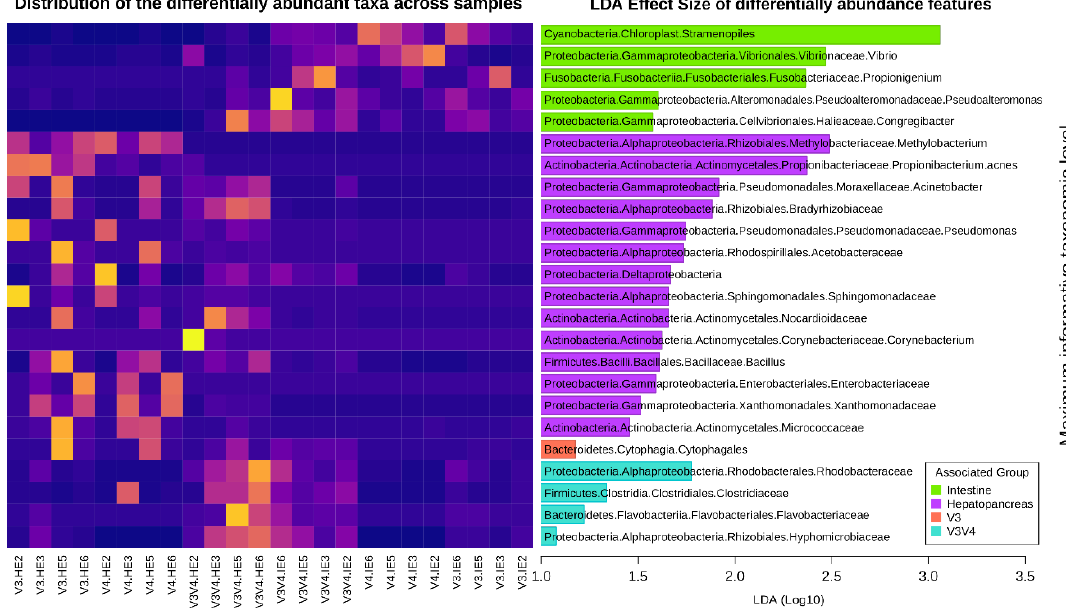
Figure 11. Distribution of differentially abundant multi-level taxa selected by the Linear discriminant analys Effect Size (LEfSe). The heatmap represents the scaled distribution (relative abundance by row) of each taxa across samples that were differentially associated with a group. Color intensity (warmth) represents relative abundances (dark blue = 0 to light yellow = 1). Only the highest taxonomic levels bearing any informative taxonomic labels and with an LDA eff size > 1 (log 10 scale) are shown. We also analyzed di ff erential taxa associated with the region-organ groups (Figure